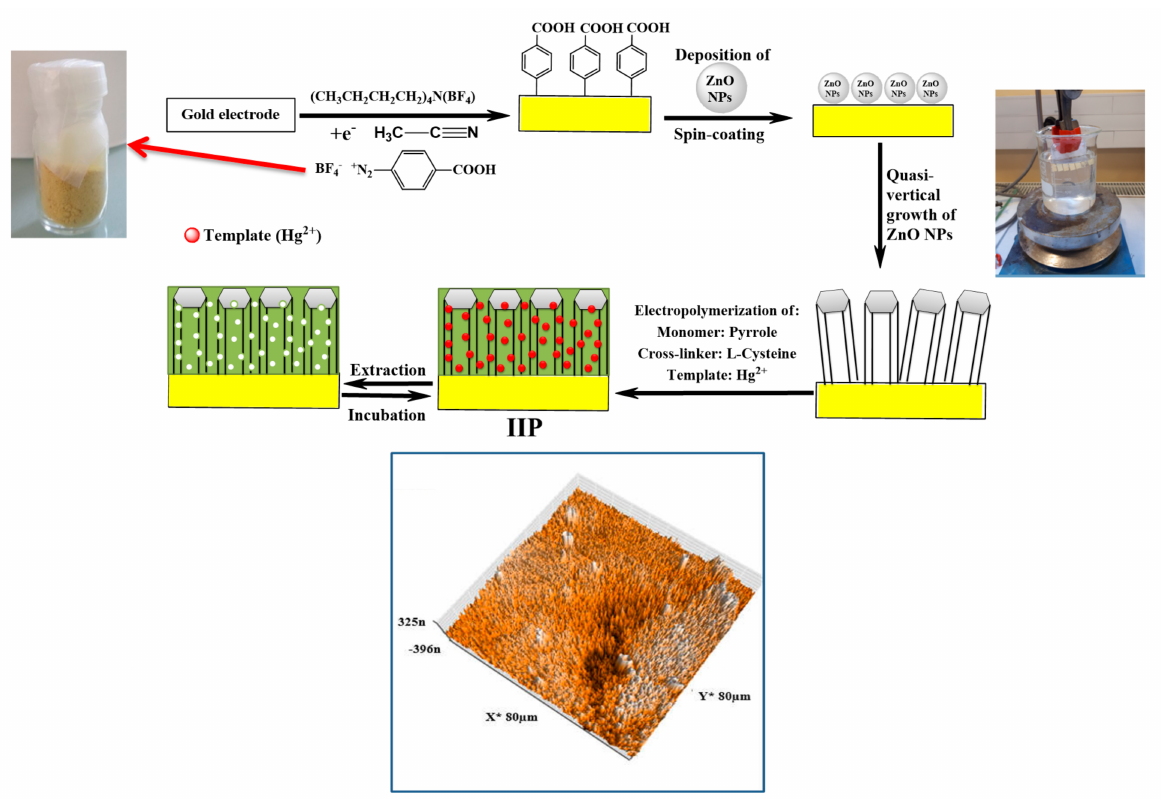
Figure 16. Top: Schmatic illustration of the stepwise synthesis of mercury imprinted PPy wrapped around vertically aligned ZnO nanorods attached to diazonium-modified gold electrodes. Bottom: (80 × 80 µ m 2 ) 3D image of Au-diazo-ZnO NRs. Reproduced from